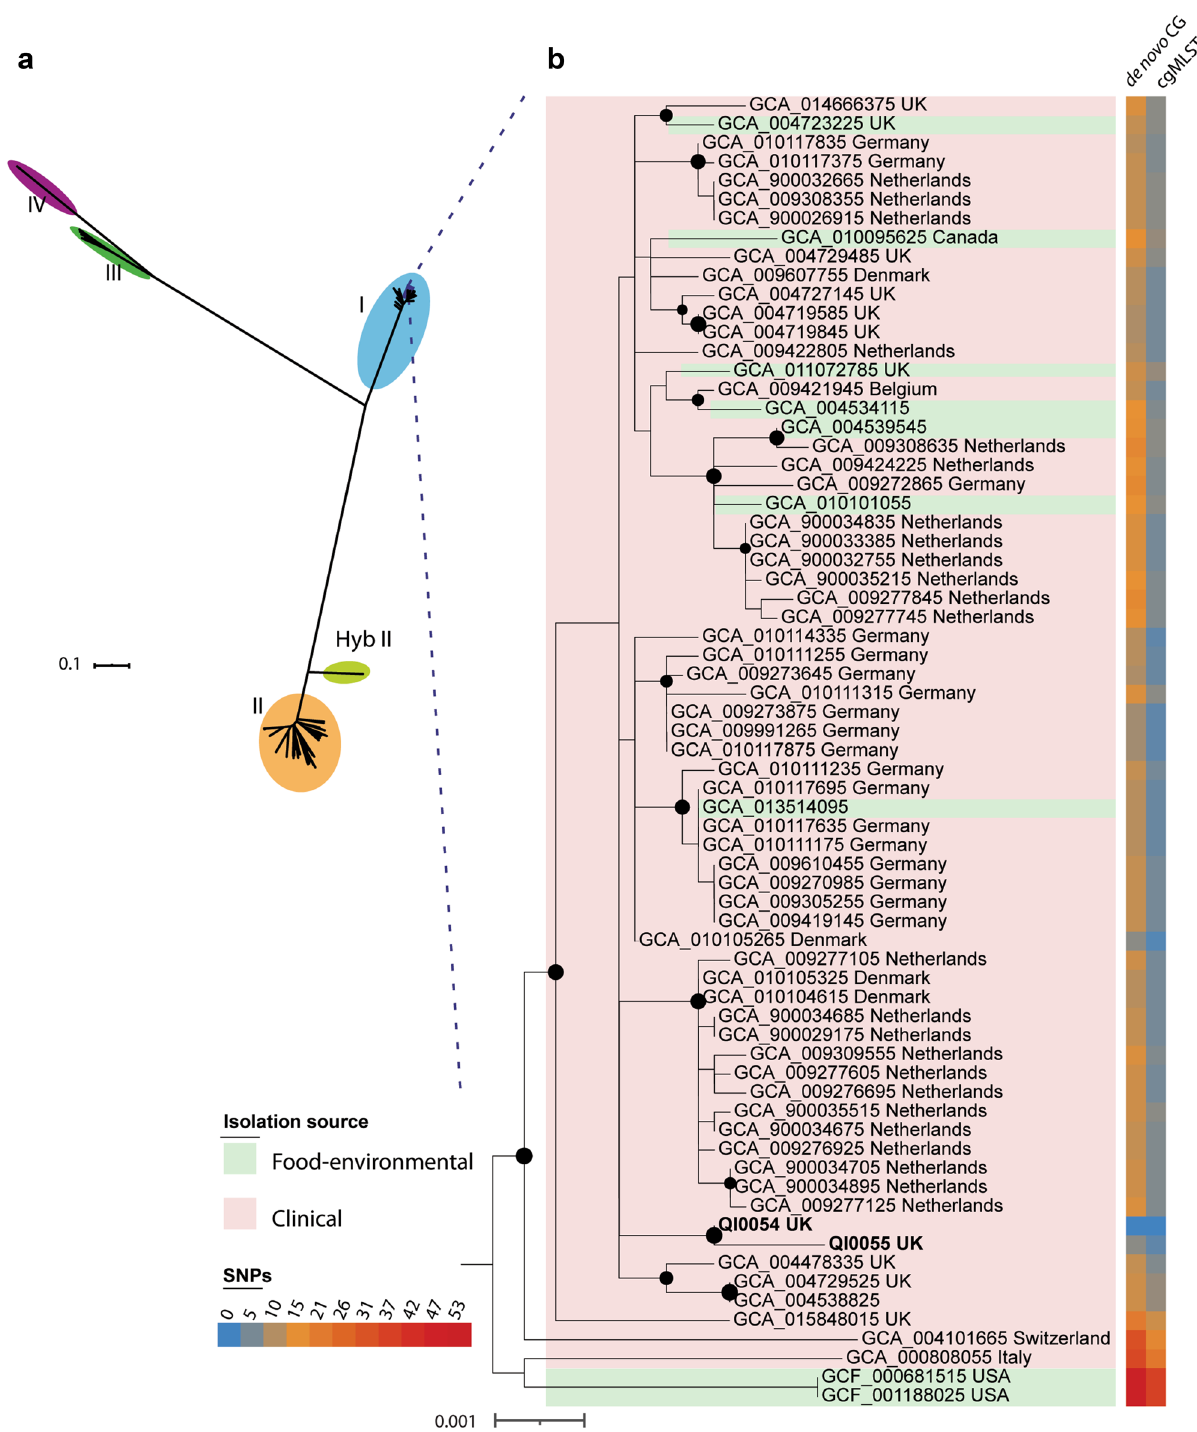
Figure 1. Closest relatives of L. monocytogenes QI0054 and QI0055 strains, and number of SNP changes. a Phylogenetic reconstruction of Listeria monocytogenes isolates determined by maximum likelihood. The tree was reconstructed using the variable positions of the 2309 core genes found among 261 Listeria genomes. The scale bar represents the mean number of nucleotide substitutions per site. b SNP phylogenetic reconstruction with the closest epidemiological relatives and the number of mutations detected using de novo calculation of the core genome (method II) or the cgMLST genes 46 (method III, see “Materials and Methods”